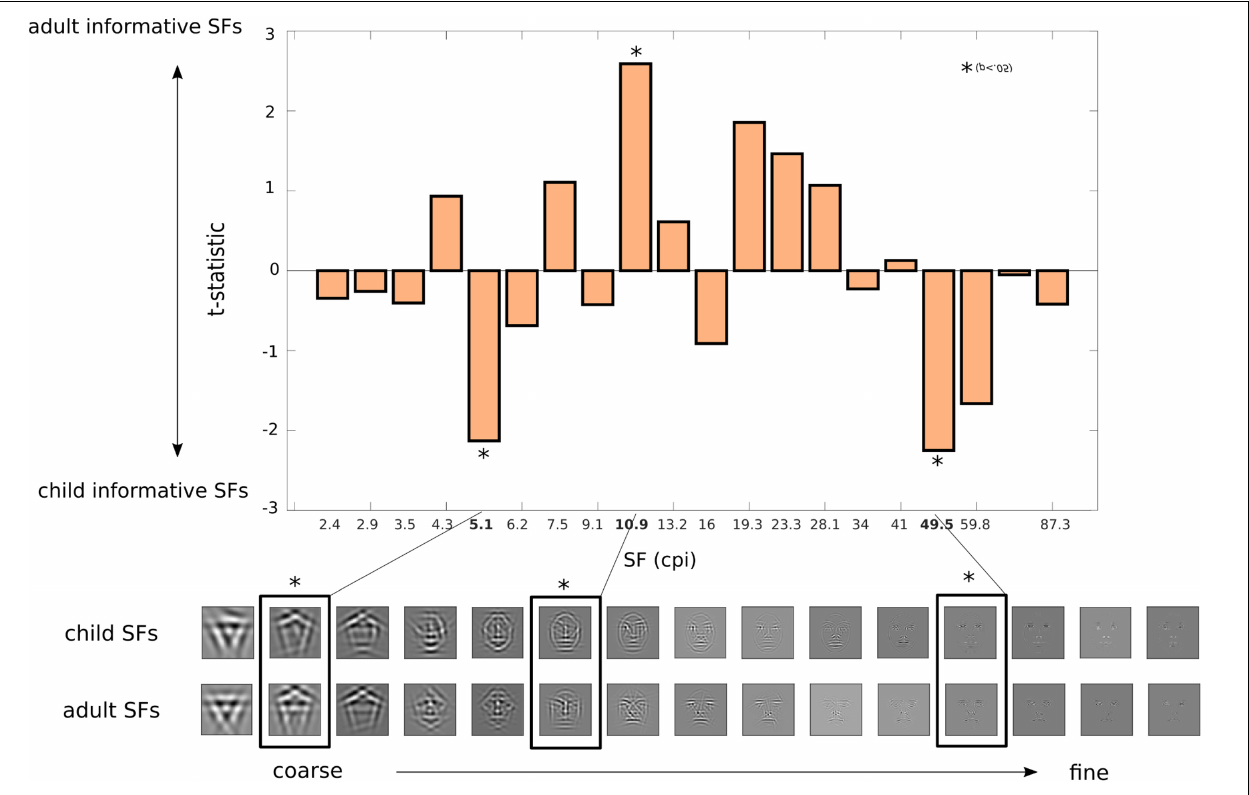
FIGURE 3 | Spatial frequency evidence for categorisation of child and adult faces. Correlation coefficients for feature granularity (for accurate classification of child and adult images) were compared between child and adult faces for each one of the 20 SF bins (2.4–87.3 cpi) with unpaired t -tests. For visualisation purposes, the lower panel images display the facial information for each of the SF bands for child and adult faces. Here, positive t -statistics shows SF evidence for child-like faces, while negative values shows SF evidence for adult-like faces. Significant SF bands – low SF of 5 cpi and high SF of 50 cpi for child faces, mid-SF of 22 cpi for adult faces – are outlined with an